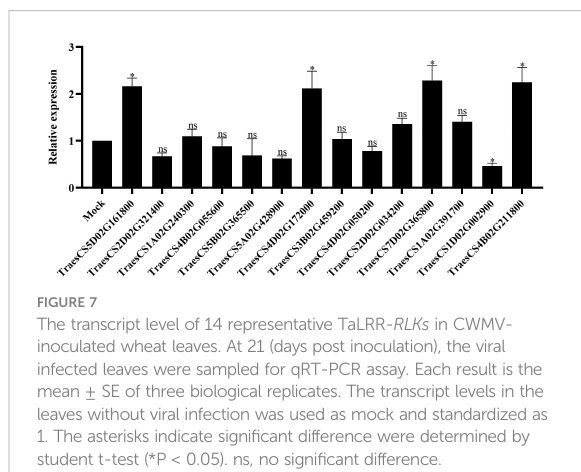
FIGURE 7 The transcript level of 14 representative TaLRR- RLKs in CWMV- inoculated wheat leaves. At 21 (days post inoculation), the viral infected leaves were sampled for qRT-PCR assay. Each result is the mean ± SE of three biological replicates. The transcript levels in the leaves without viral infection was used as mock and standardized as 1. The asterisks indicate signi fi cant difference were determined by student t-test (*P < 0.05). ns, no signi fi cant